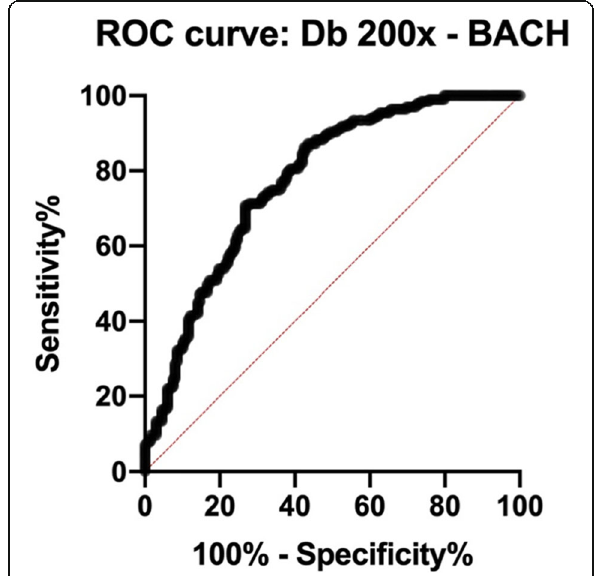
Fig. 6 ROC curve produced from the comparison between images assigned as normal and benign and in situ and invasive